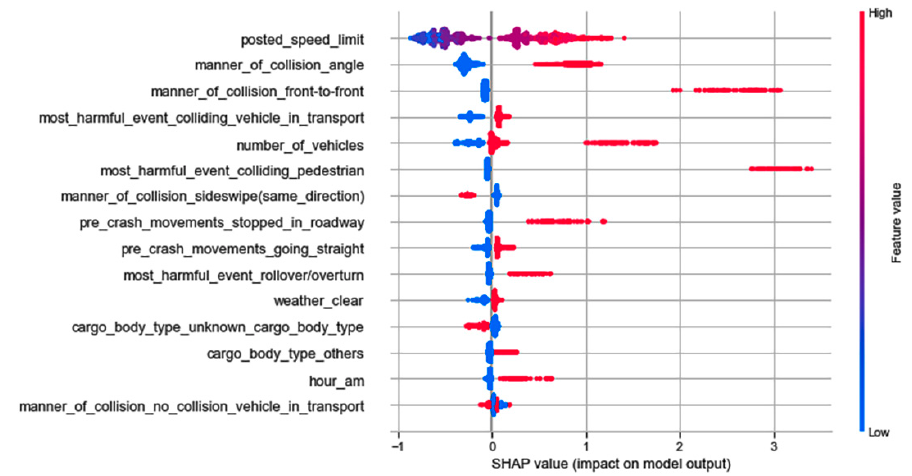
Figure 3. Summary plot for top 15 important features in CL1-based model.